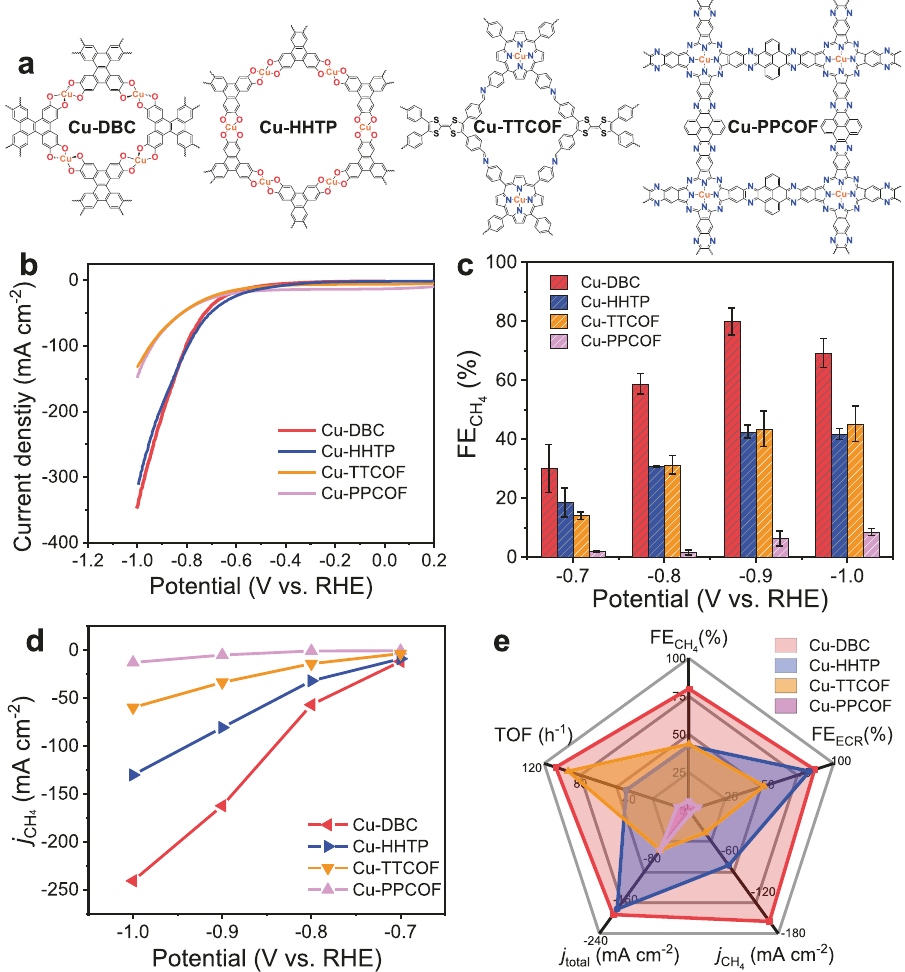
Fig. 3 ECR performances of crystalline single-site Cu electrocatalysts. a The formula diagrams. b LSV polarization curves. c Faradaic ef fi ciencies (FEs) for CH 4 recorded at different applied potentials. d Partial CH 4 current densities. e Overall ECR performance evaluation at − 0.9 V vs.